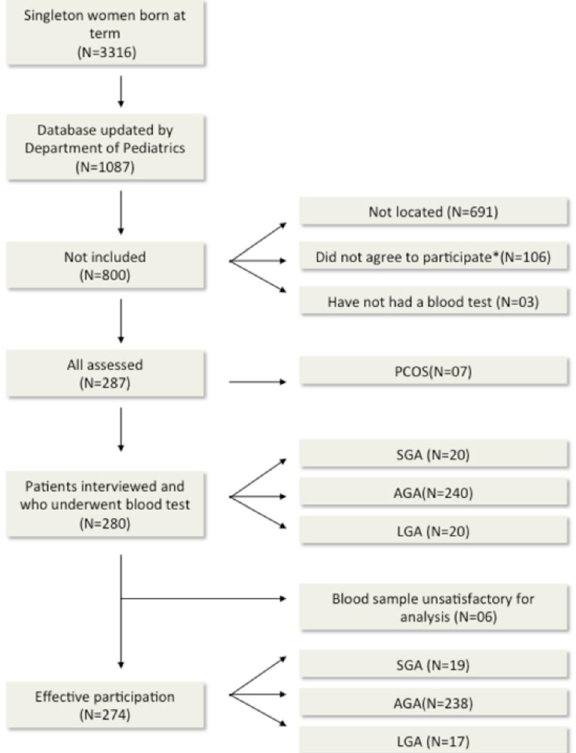
Figure 1. Flow chart of the study. Did not accept to participate: 83 patients refused to participate due to lack of time; 6 changed address and could not be located, 4 were breastfeeding; 9 were pregnant; 1 died; 1 performed recent bariatric surgery at the time of the call; 1 was in a vegetative state and 1 was deficient and could not leave home unattended. PCOS- Polycystic ovary syndrome. AGA, adequate for gestational age; SGA, small for gestational age; LGA, large for gestational